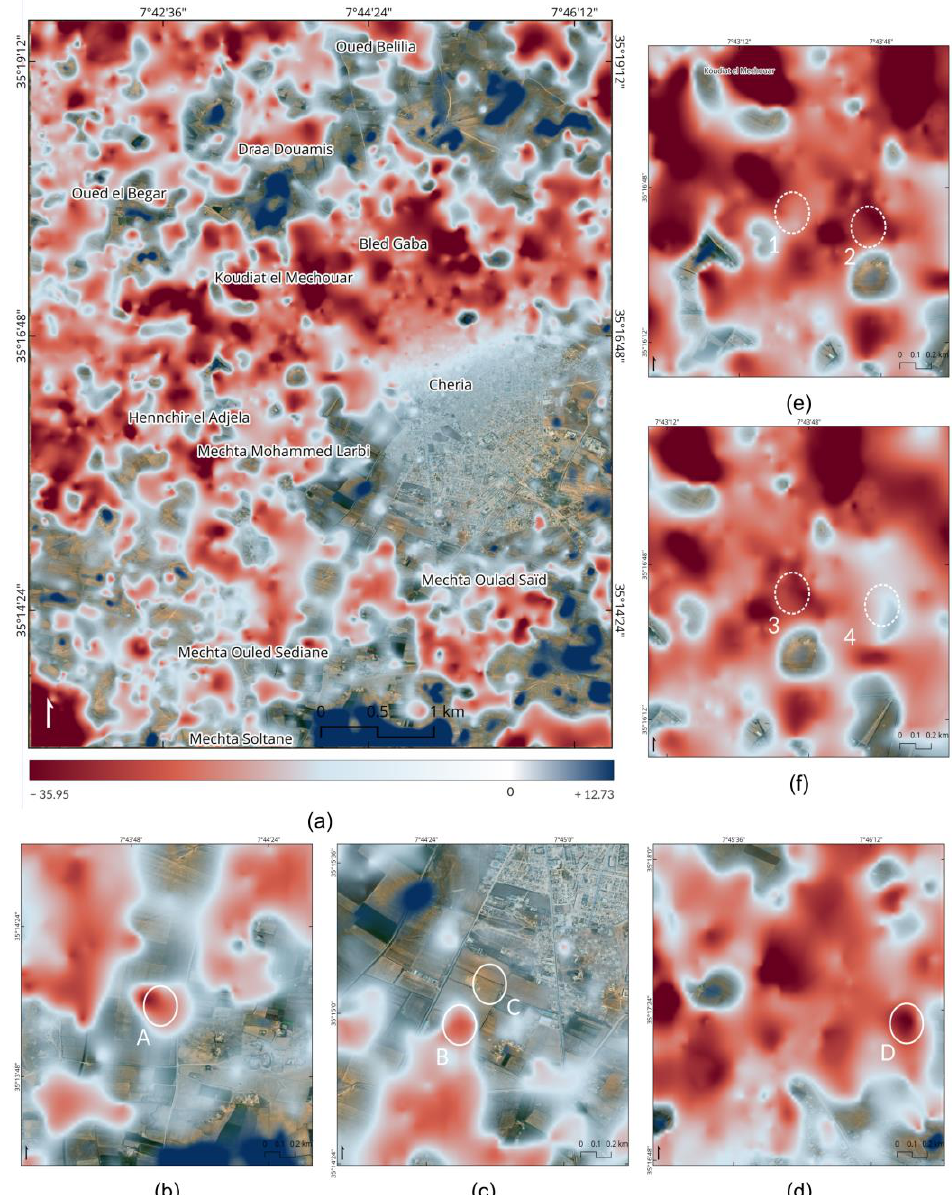
Figure 8. ( a ) Positions and overview of the eight selected sample sites (A, B, C, and D through the AB profile, and 1, 2, 3, and 4 through the CD profile) from Figure 7; ( b – f ) represent a close-up overview of selected sample sites (i.e., highlighted with white circles).